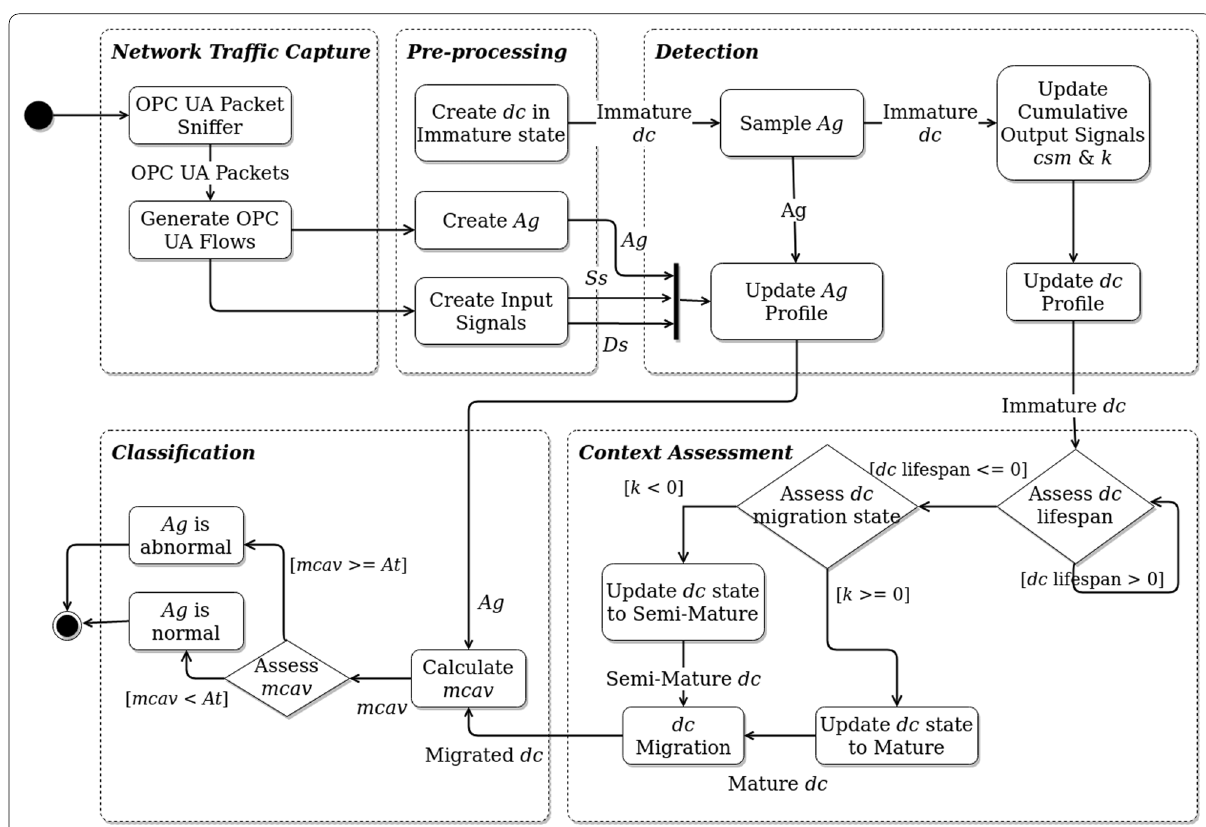
Fig. 2 Activity diagram of the iDCA-based network